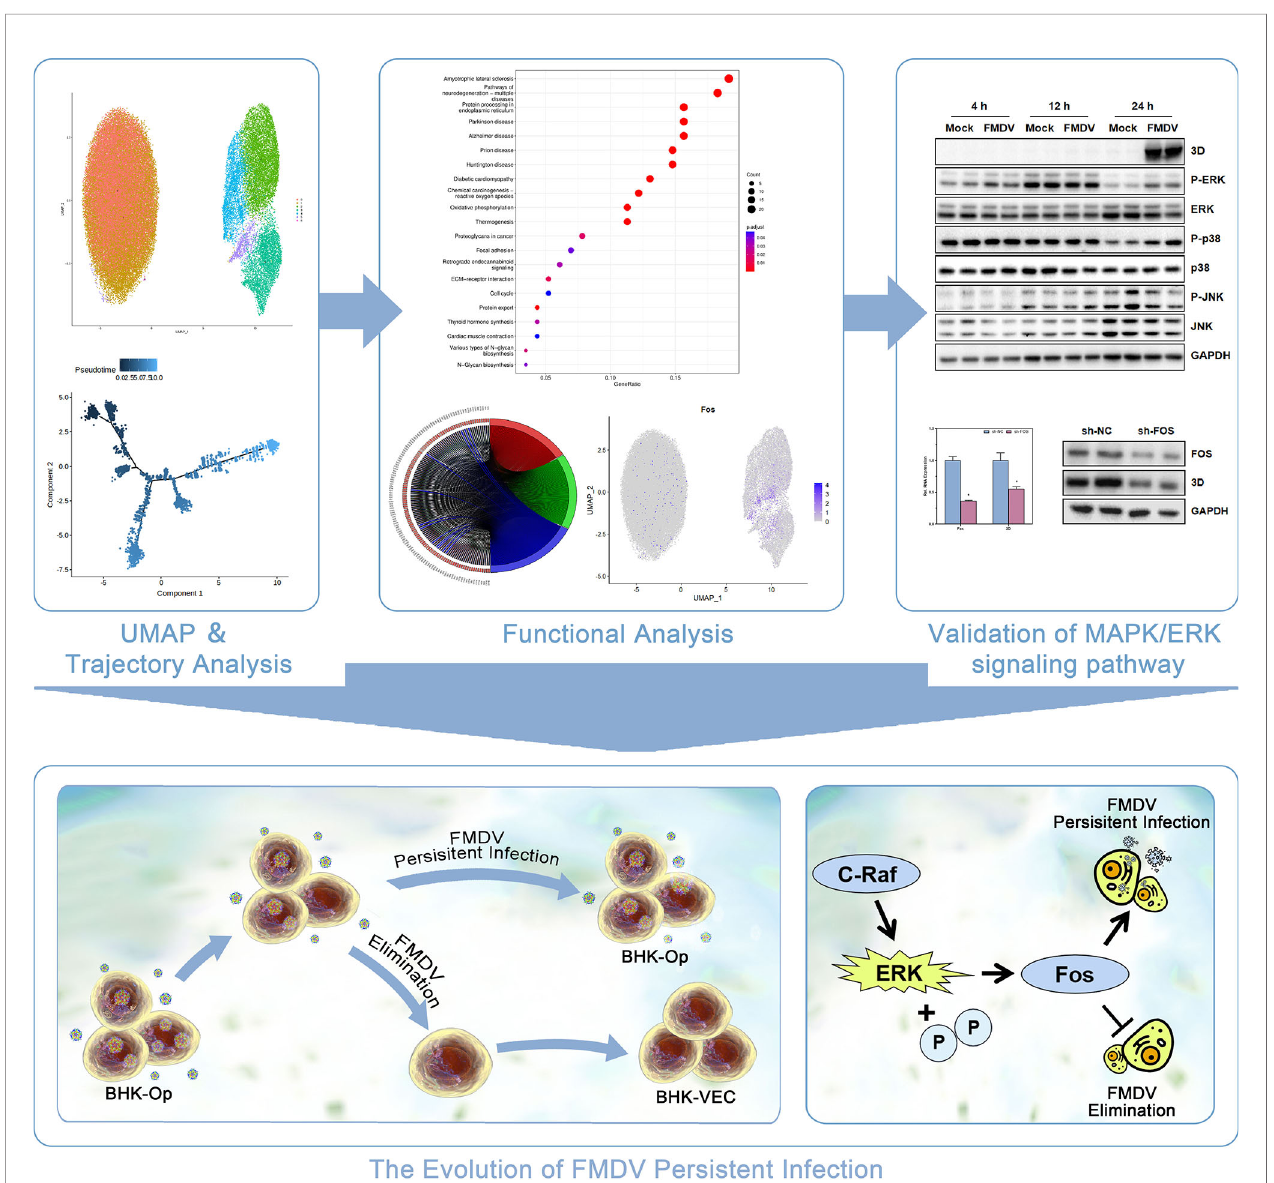
FIGURE 7 | The schematic diagram depicting the regulation of MAPK/ERK signaling pathway on the evolution FMDV-persistent